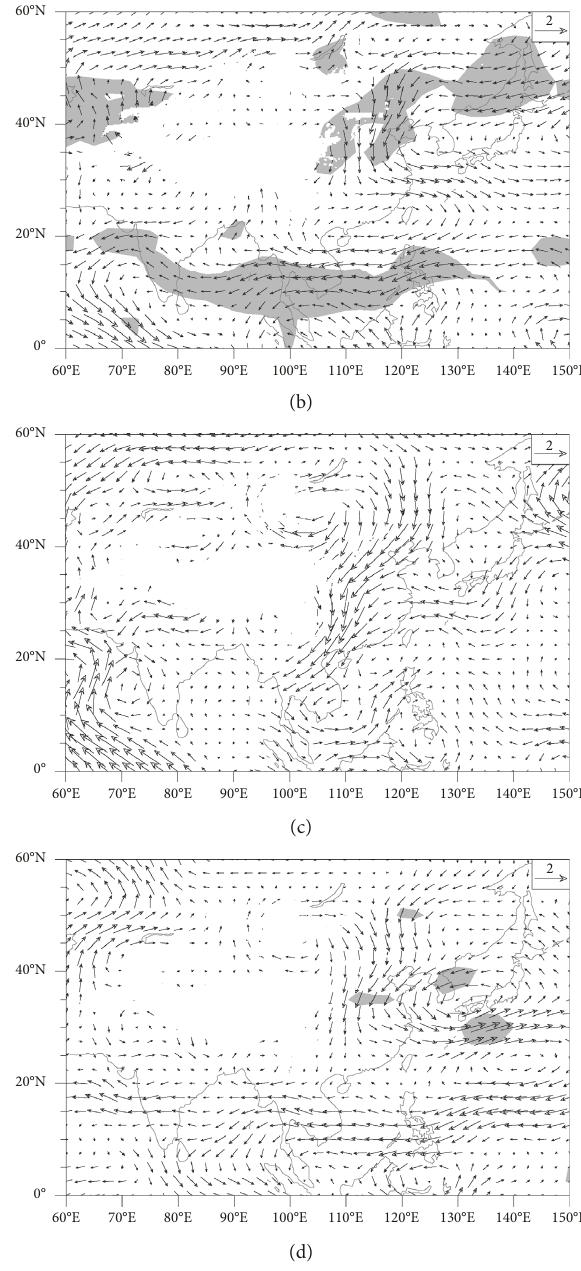
Figure 4: 850hPa wind (vectors; scale in m s − 1 ) of strong (a) and weak (b) APO years during 1948–1990 and (c) strong and (d) weak APO years during 1991–2016. The shaded area indicates significant correlation at 95% confidence level based on Student’s t